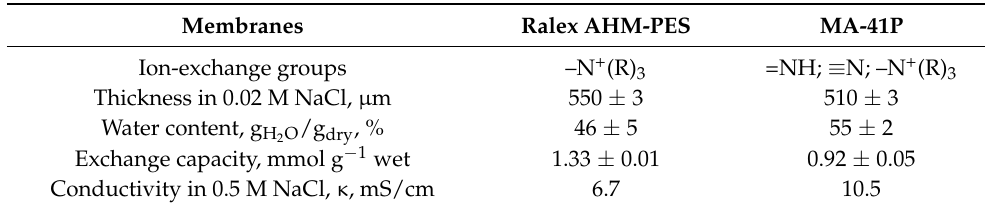
Table 1. Some of the characteristics of the commercial membranes under study. Results are summa- rized from those found in